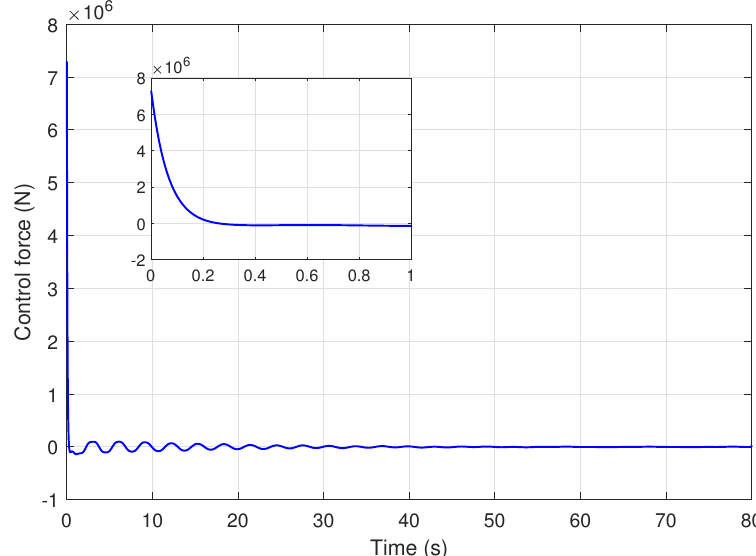
Figure 9. Control force by NES–NOC–1.